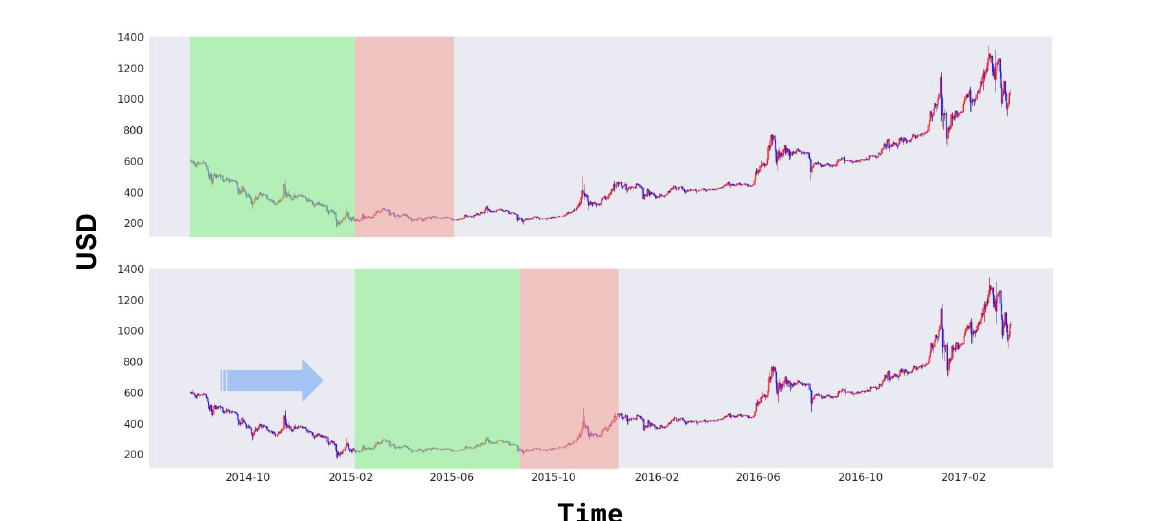
Figure 1. Visualization for walk-forward optimization. It uses the data points in a train window (green box) and a test window (red box), one at a time. After finishing training a model with the dataset, the two windows move to the right, and training begins again until the windows hit the end of the time